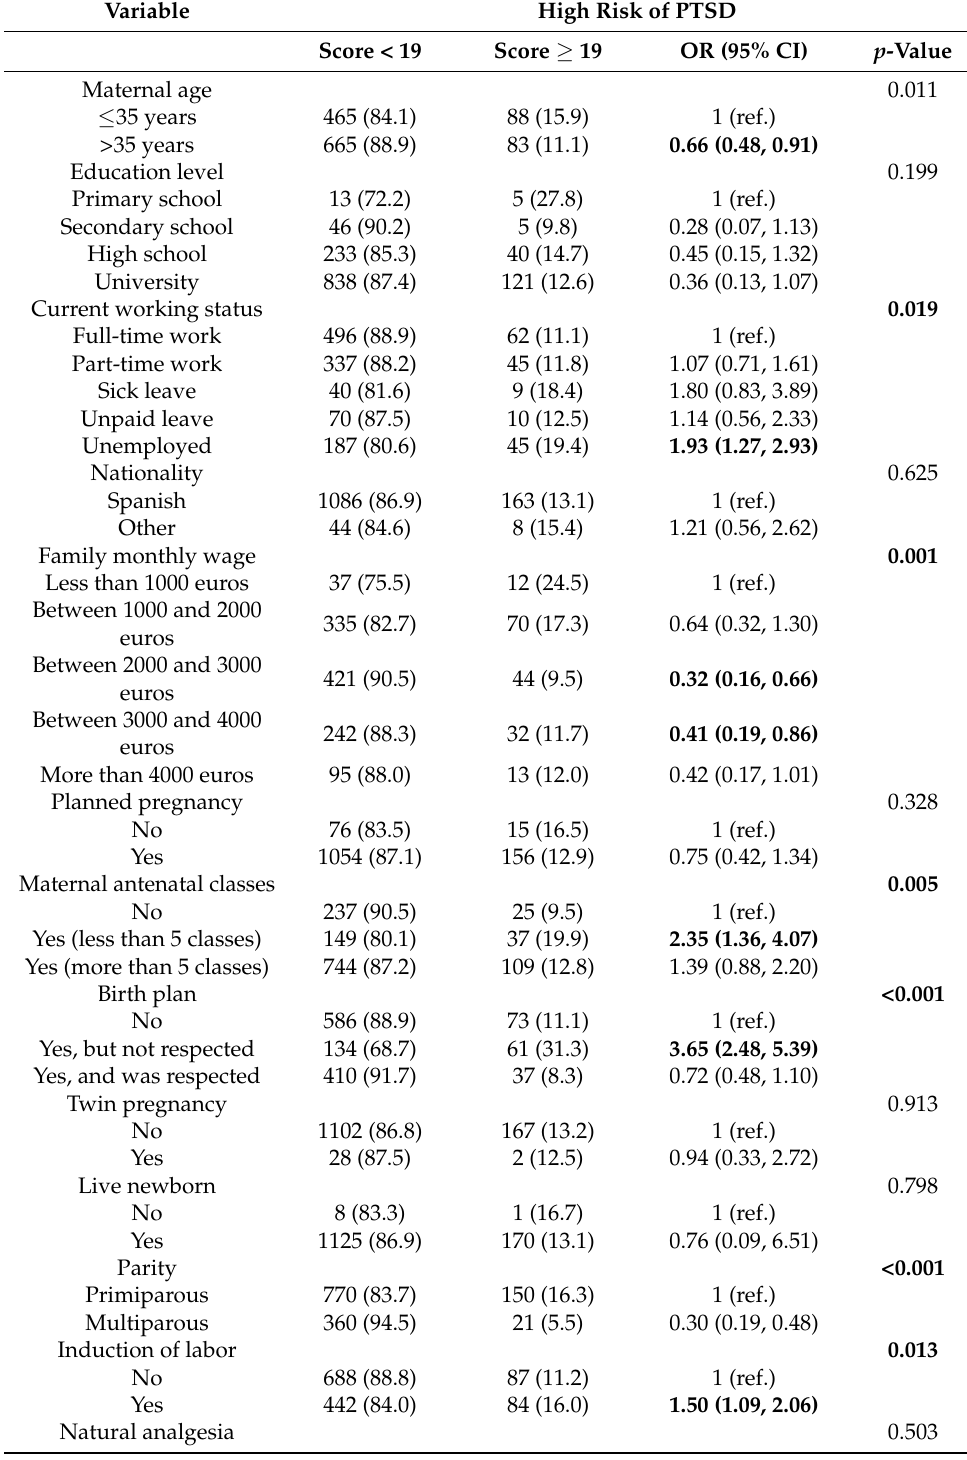
Table 2. Bivariate analysis between sociodemographic or obstetric characteristics and high risk of post-traumatic stress disorder